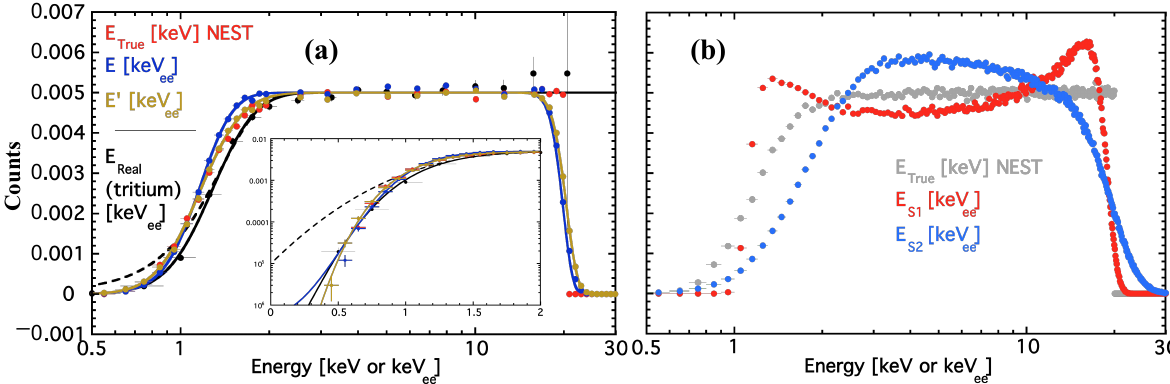
Figure 4. ( a ) Histogram of 10 6 NEST uniform- E -spectrum events (0–20 keV true) binned using MC truth energies (red), reconstructed energy from the combined scale (blue), and re-weighted optimal reconstruction (gold). Gold outperforms blue even visually, correcting underestimation of efficiency sub-keV, plus overestimation near 1.5 keV (see the text for quantitative goodness of fit comparisons). Tritiated methane (CH 3 T) is the black points, for validation against actual data. Its efficiency curve is markedly similar despite a non-flat spectrum. As it is continuous, the E is still only reconstructed, not known to infinite precision as in MCs, although an attempt to empirically account for smearing was made by LUX [76,79]. The solid black line is the Gompertz fit, superior to a more traditional erf , dashed, while the inset zooms on low energies for clarity, with a linear x-axis and log y now. ( b ) The true E s repeated in gray, but now compared to S1 (red) and S2-only (cyan) scales (Equations (2) and (3)), with the former possessing unnatural peaks at left and right, and the latter grossly underestimating efficiency at keV scales. The default public beta model (NEST v2.2.0) is used here but comparable results occur with gamma